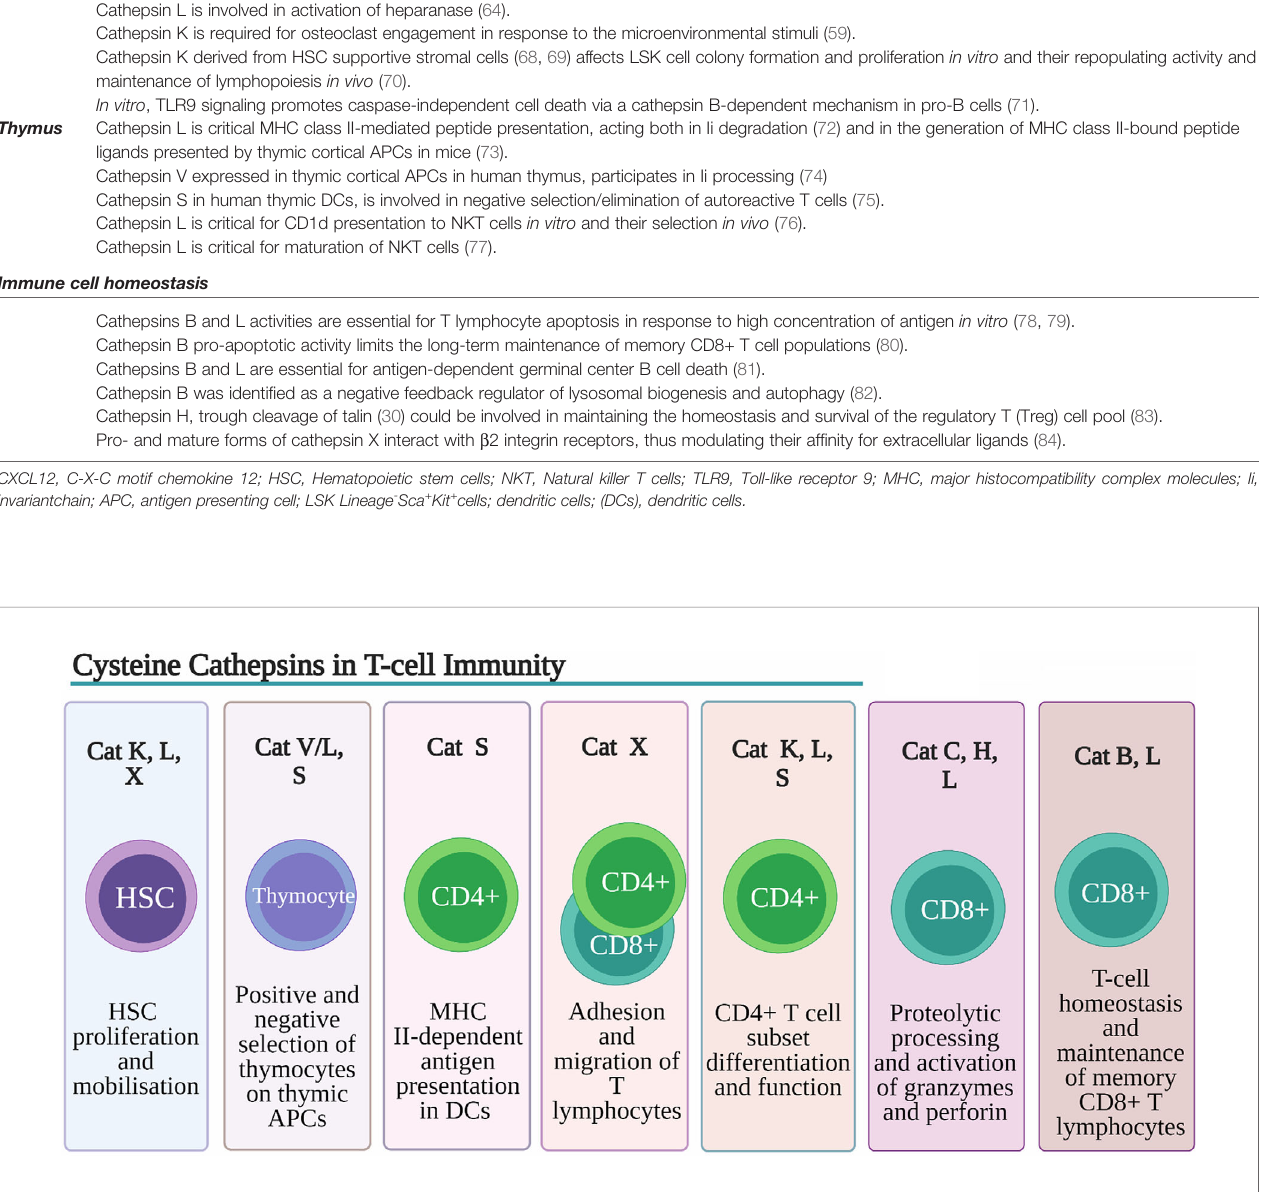
FIGURE 2 | Role of Cysteine Cathepsins in T-cell immunity. Despite their overlapping substrate speci fi cities several cysteine peptidases have been shown to play non-redundant roles in development, function and homeostasis of T cells. Cathepsin K (Cat K), cathepsin L (Cat L) and cathepsin X (Cat X) are involved in remodeling of extracellular matrix (ECM) and degradation of chemokines, necessary for hematopoietic stem cells (HSCs) proliferation and retention within the HSC niche. Cat L, in mouse cortical thymic antigen presenting cells (APC) and cathepsin V (CatV) in human APC, are indispensable for degradation of invariant chain (Ii) to class II-associated invariant chain peptide (CLIP) necessary for the process of positive thymic selection. In human professional APCs cathepsin S (Cat S) was shown to be indispensable for MHC class II antigen presentation. By regulating toll-like receptor (TLR) 9 and TLR7 signaling in dendritic cells (DC) CatK affects Th17 polarization. Cathepsin S (CatS), through activation DC protease-activated receptor-2 (PAR2) and upregulation of IL-6 secretion drives splenic DC-dependent Th17 differentiation. Cat K through cleavage of TLR7 blocks immuno-suppressive activity regulatory T cells (Tregs). Through processing of b 2 integrin receptors Cat X modulates their af fi nity for extracellular ligands thus affecting the adhesion and migration of T lymphocytes. Cat C and cathepsin H (Cat H) are involved in proteolytic processing and activation of granzymes, main effector molecules of CD8+ cytotoxic lymphocytes whereas Cat L has been implicated in processing and activation of perforin.